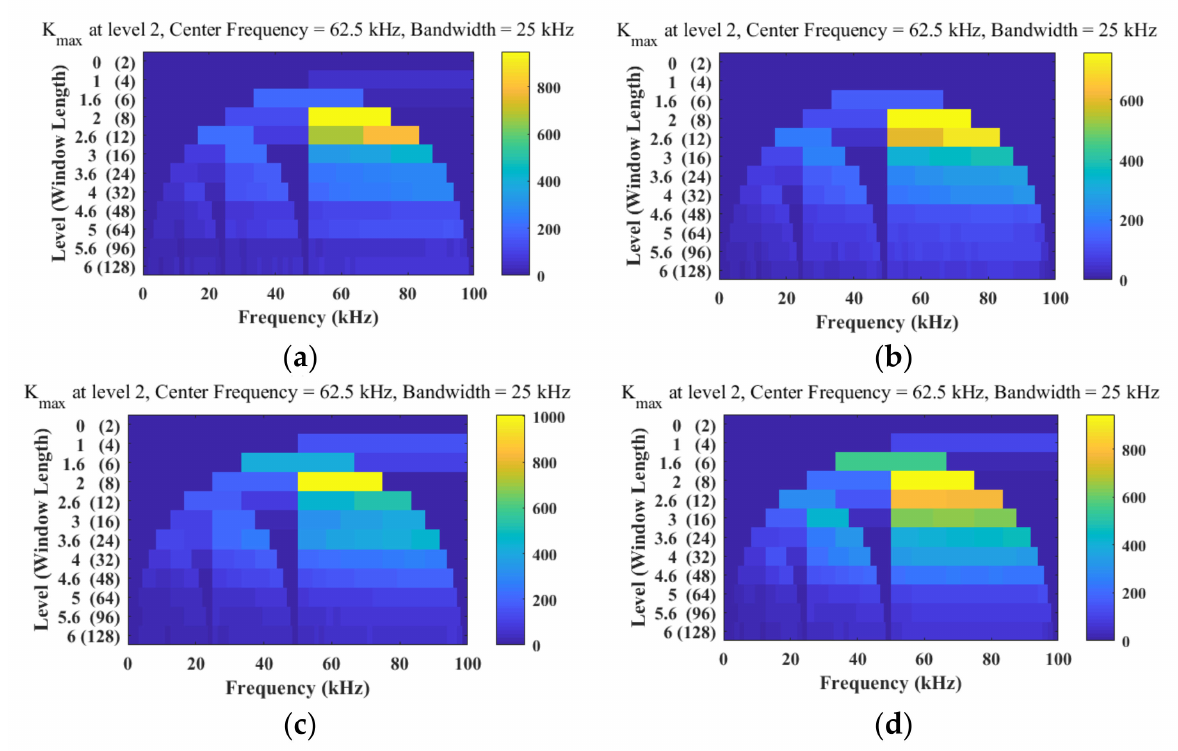
Figure 7. Current spectrum kurtosis diagrams on both sides of the line during internal and external faults: ( a ) current kurtosis diagram on the M side in an internal fault; ( b ) current kurtosis diagram on the N side in an internal fault; ( c ) current kurtosis diagram on the M side in and external fault; ( d ) current kurtosis diagram on the N side in external